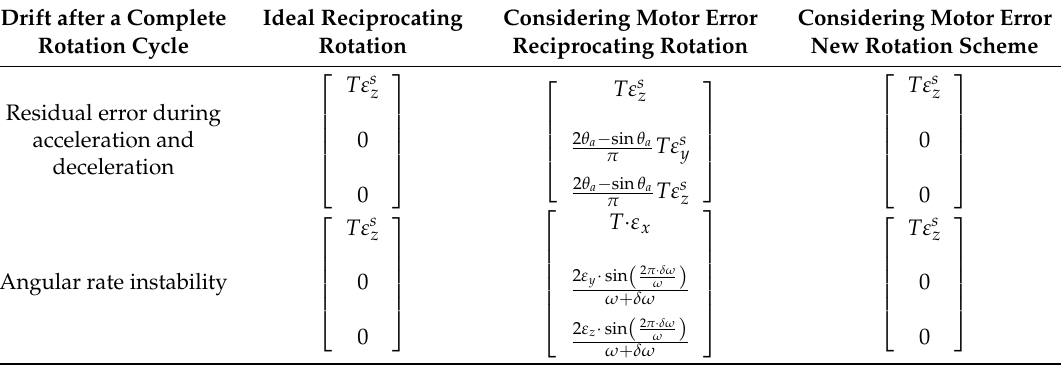
Table 1. Constant drift modulation effect after one cycle of different rotation schemes.